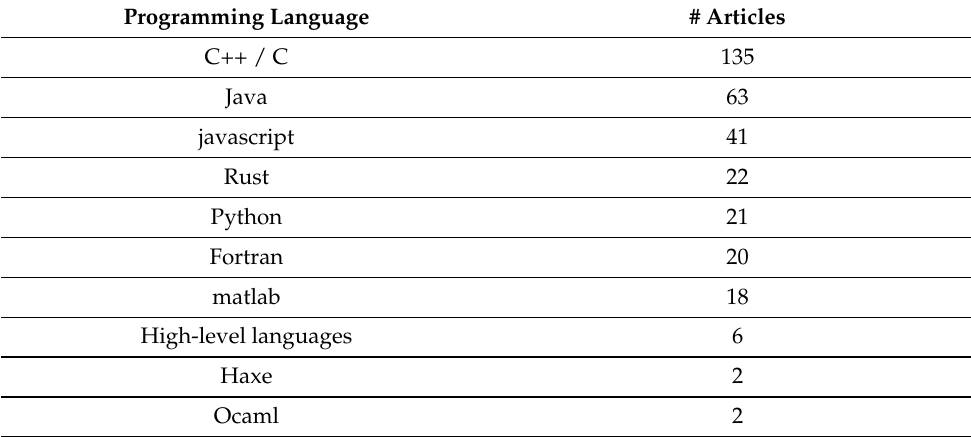
Table 15. Top 10 most recurrent programming languages.